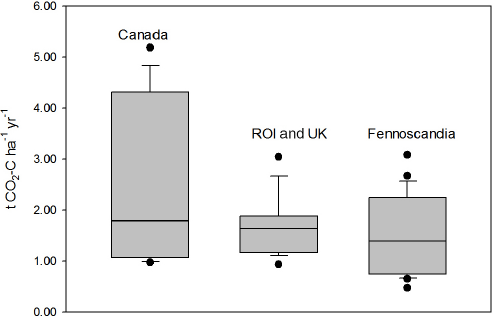
Figure 7. Carbon dioxide emissions (tCO 2 -Cha − 1 yr − 1 ) from peatlands managed for extraction in Canada, the ROI and the UK (this study) and Fennoscandia. The 10th and 90th percentile are in- dicated by the bars, the 25th and 75th percentiles with the top and bottom of the box and the median value by the centre line. (Data for Canada and Fennoscandia taken from the following studies; Tuit- tila and Komulainen, 1995; Sundh et al., 2000; Waddington et al., 2002; Glatzel et al., 2003; McNeil and Waddington, 2003; Tuittila et al., 2004; Cleary et al., 2005; Alm et al., 2007a; Shurpali et al., 2008; Waddington et al., 2010; Järveoja et al., 2012; Mander et al., 2012; Salm et al., 2012; Strack et al., 2014.) Where studies reported seasonal fluxes (typically May to October), these were converted to annual fluxes by assuming that 15% of the flux occurs in the non- growing season (Saarnio et al.,